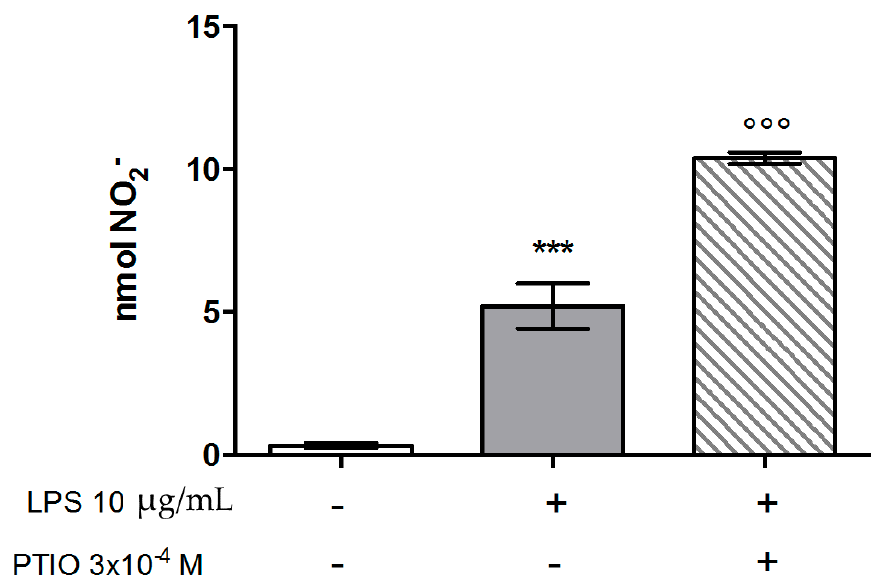
Figure 1. Nitric oxide (NO) release in the extracellular medium by macrophages. Murine peritoneal macrophages were treated for 24 h with 10 μ g/mL lipopolysaccharide (LPS) and with 3 × 10 − 4 M 2-phenyl-4,4,5,5-tetramethylimidazoline-1-oxyl 3-oxide (PTIO), then NO release in the extracellular medium was measured by the Griess test. Data are the mean ± standard error medium (S.E.M.) of five samples per group. Unpaired t -test: *** p < 0.001 vs. no LPS no PTIO; °°° p < 0.001 vs. LPS.